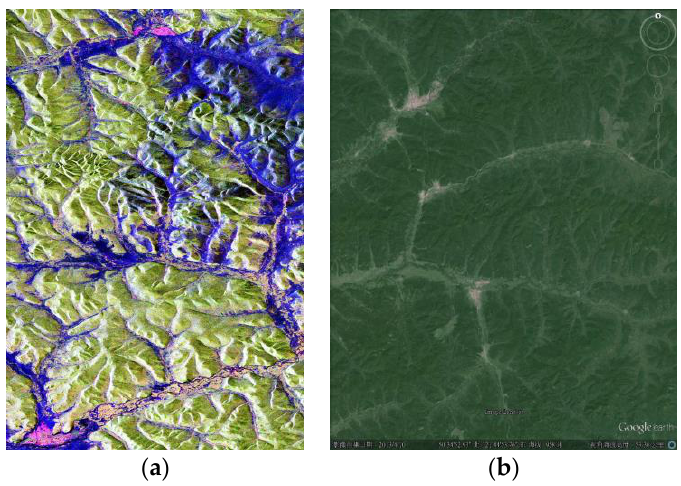
Figure 5. Test data sets in Genhe, the Great Xing'an Mountain area, China: ( a ) ALOS PALSAR data; and ( b ) optical data. Table 2. Description of the in-situ measurements of forests in the Remningstorp area.